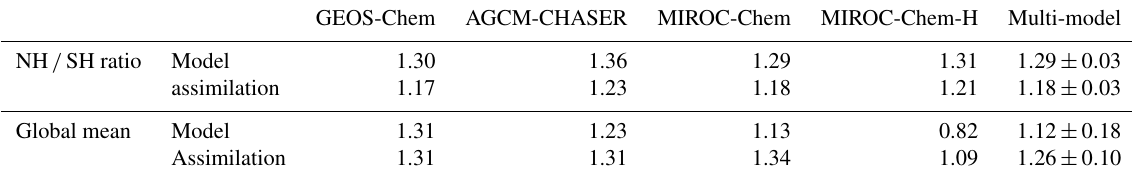
Table 6. Interhemispheric gradient (NH / SH) and global mean (with area weight) concentration (10 6 moleculescm − 3 ) of tropospheric mean OH (averaged between the surface and 300hPa) from the control and data assimilation runs. The results are shown for individual models and the multi-model mean (mean ± 1 σ